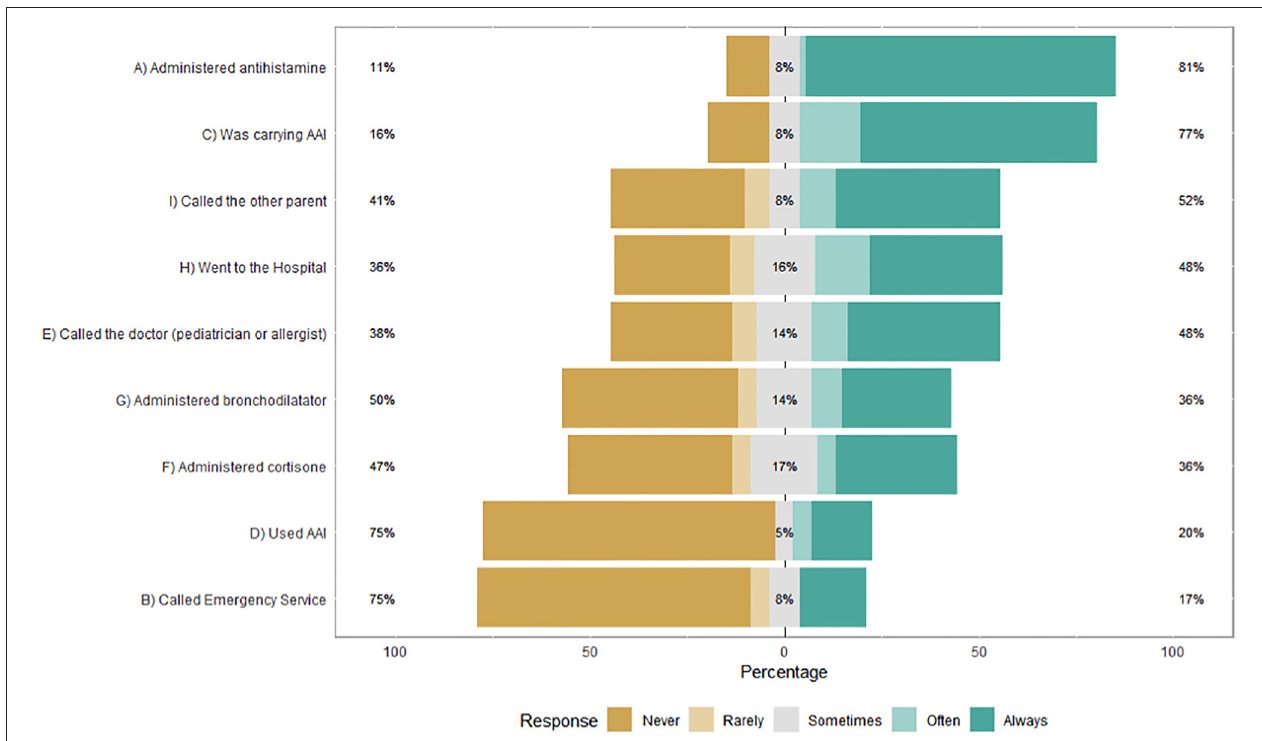
FIGURE 1 | Parental responses on previous management of their child’s anaphylaxis ( N =